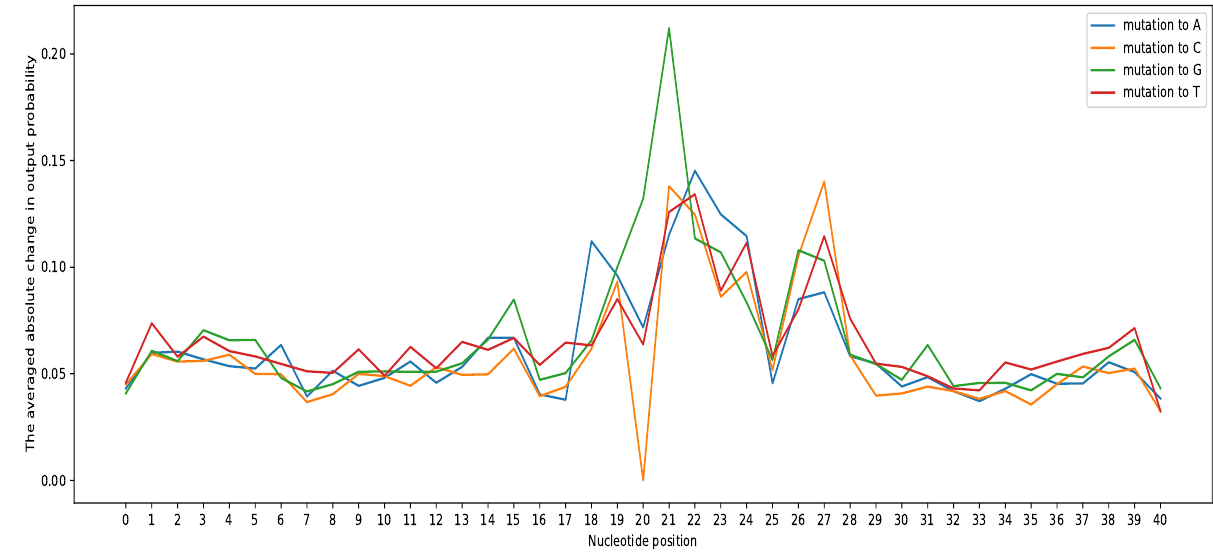
Figure 6. The effect of the mutations on the prediction probability in G. subterraneus